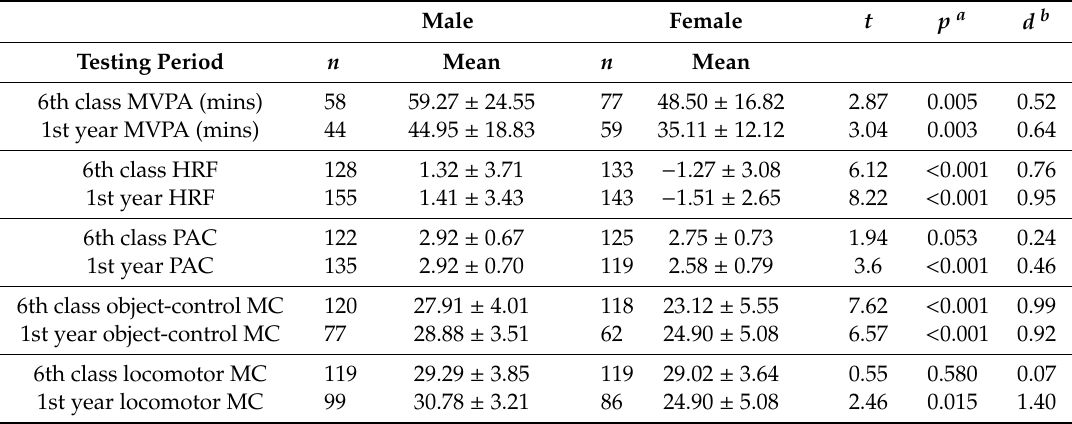
Table 4. Descriptive statistics for measured